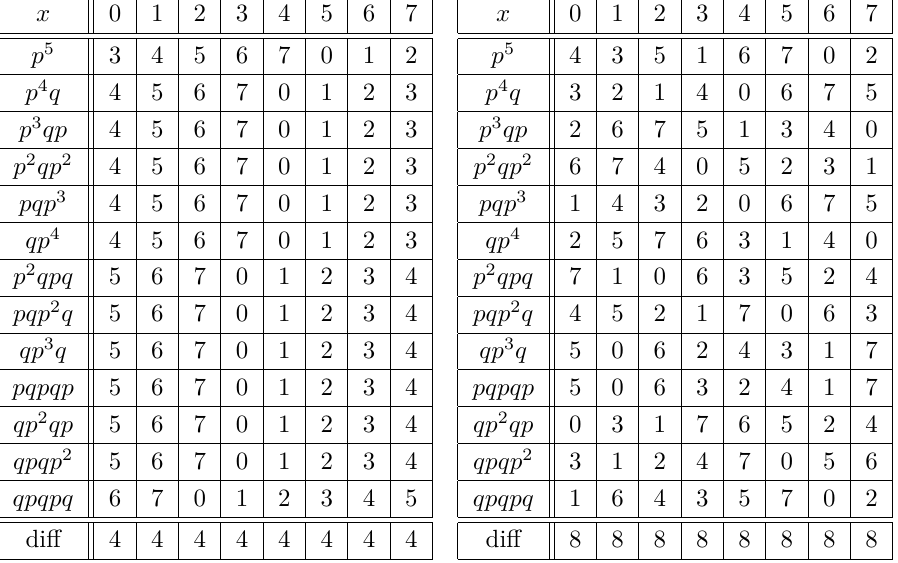
Table 1: Diffusion tables for the cyclical shift (left table) and one optimal permutation proposed by [CGT19] (right